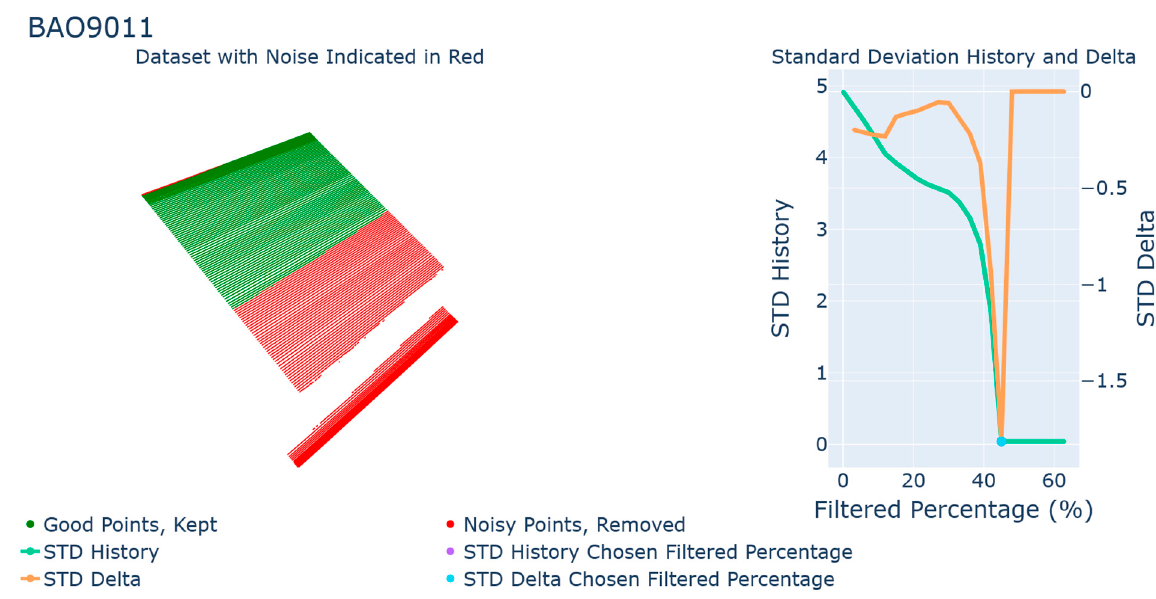
Figure 10. Results for the brushed aluminum part at +25° after 90° rotation, overexposed.